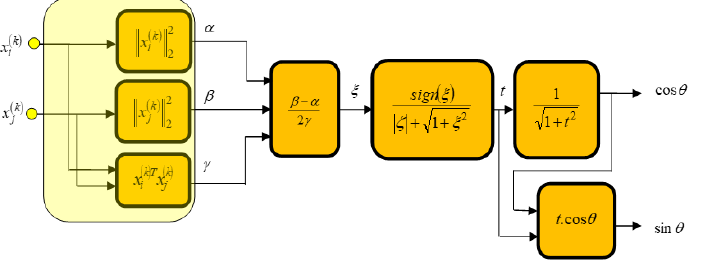
Figure 14. Part 3 (IP Angle Calculation).